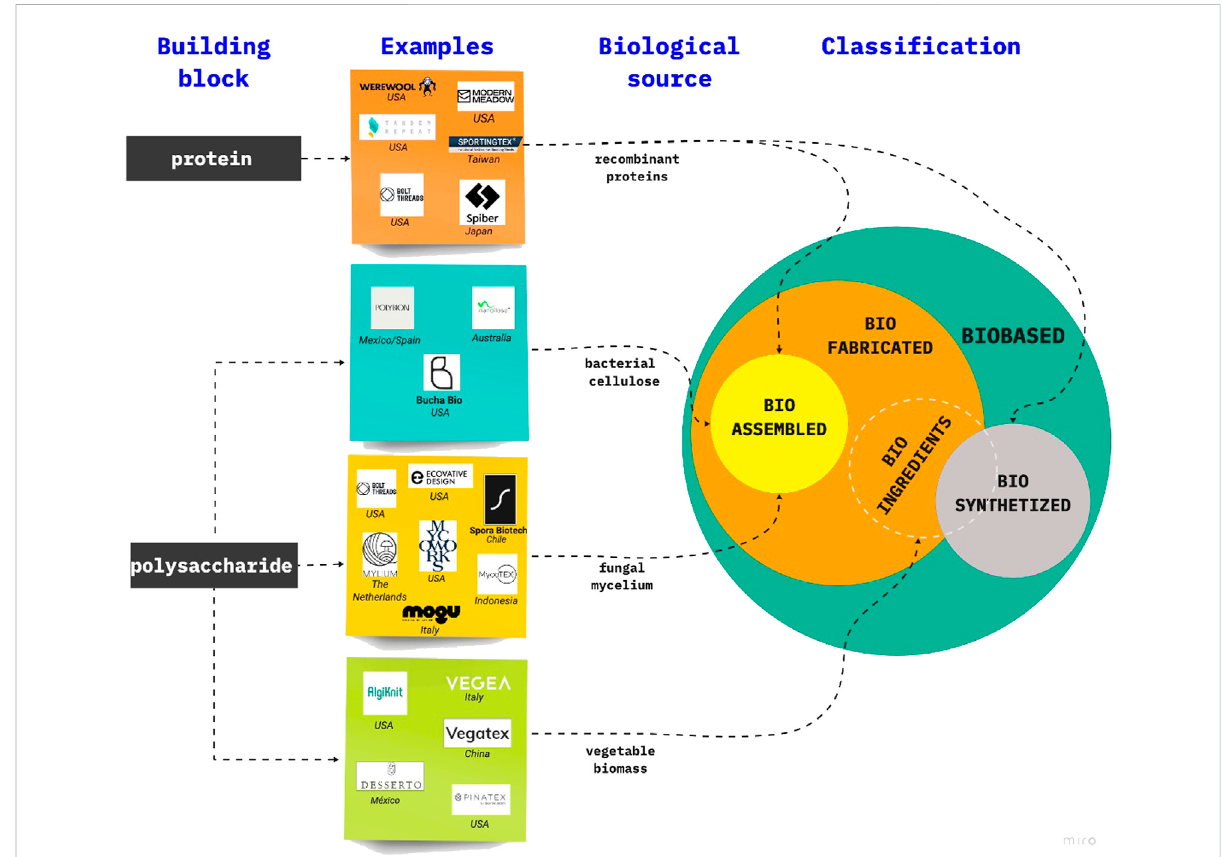
(Supplementary Table S1) presented in the